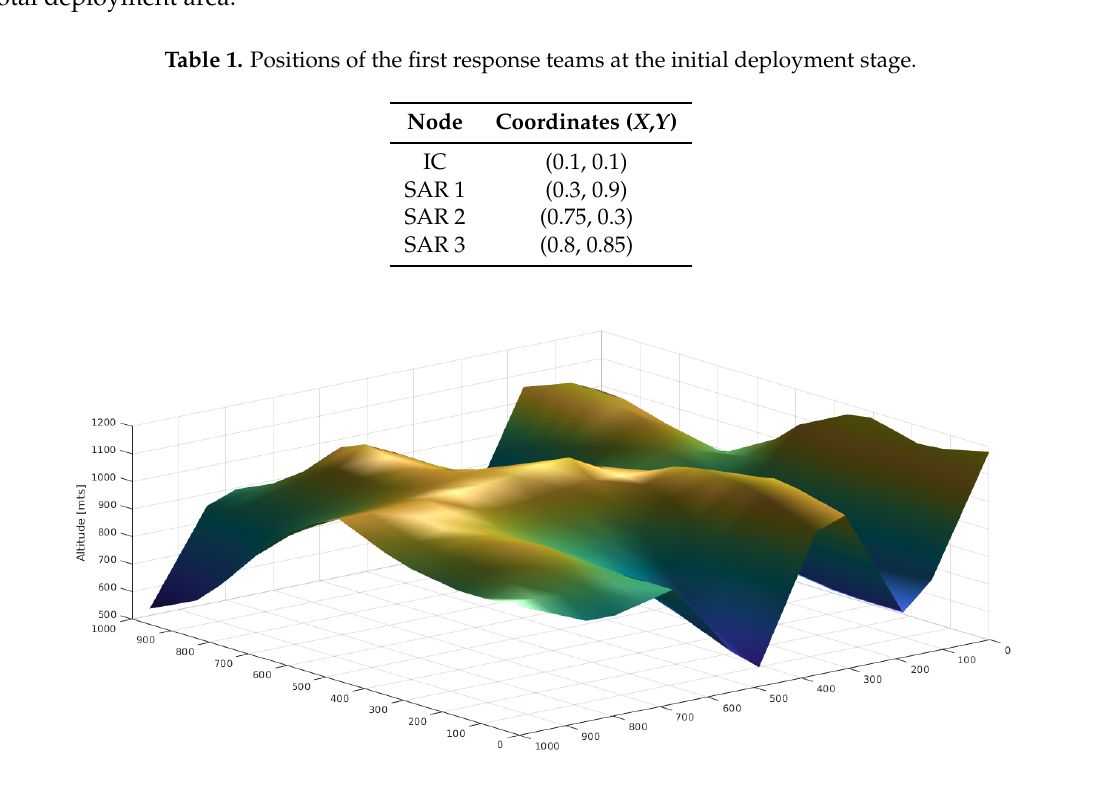
Figure 6. Terrain elevation map considered in the deployment